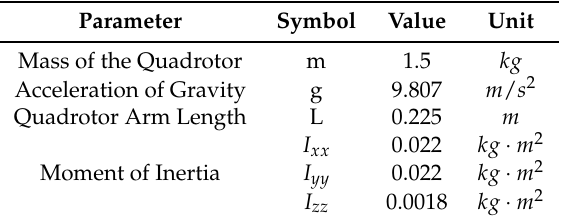
Table 4. Parameters of the